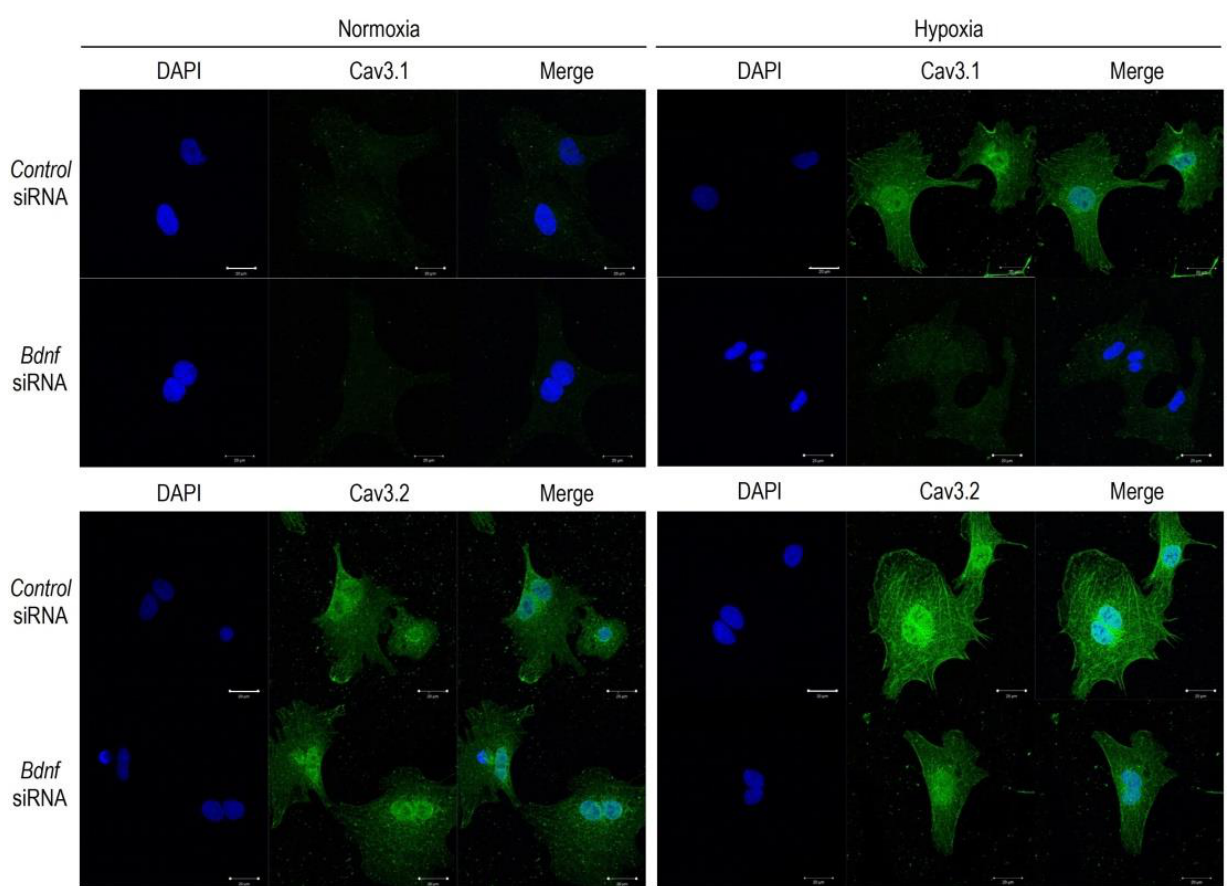
Figure 6. Immunocytochemistry staining for the detection of the Cav3 channels and the effect of hypoxic insult with Bdnf silencing in cardiomyocytes. Expression of Cav3.1 and Cav3.2 (green) are presented. Nuclei were counterstained with DAPI (blue). Actions of Bdnf knockdown were assessed by use of control-siRNA (scramble siRNA, 10 nM) or bdnf -siRNA (10 nM) transfected with Lipofectamine RNAiMAX for 48 h. After transfection, cardiomyocytes were exposed to normoxia (21% O 2 ) or hypoxia (1% O 2 ) for 3 h. Scale bar = 20 μm.